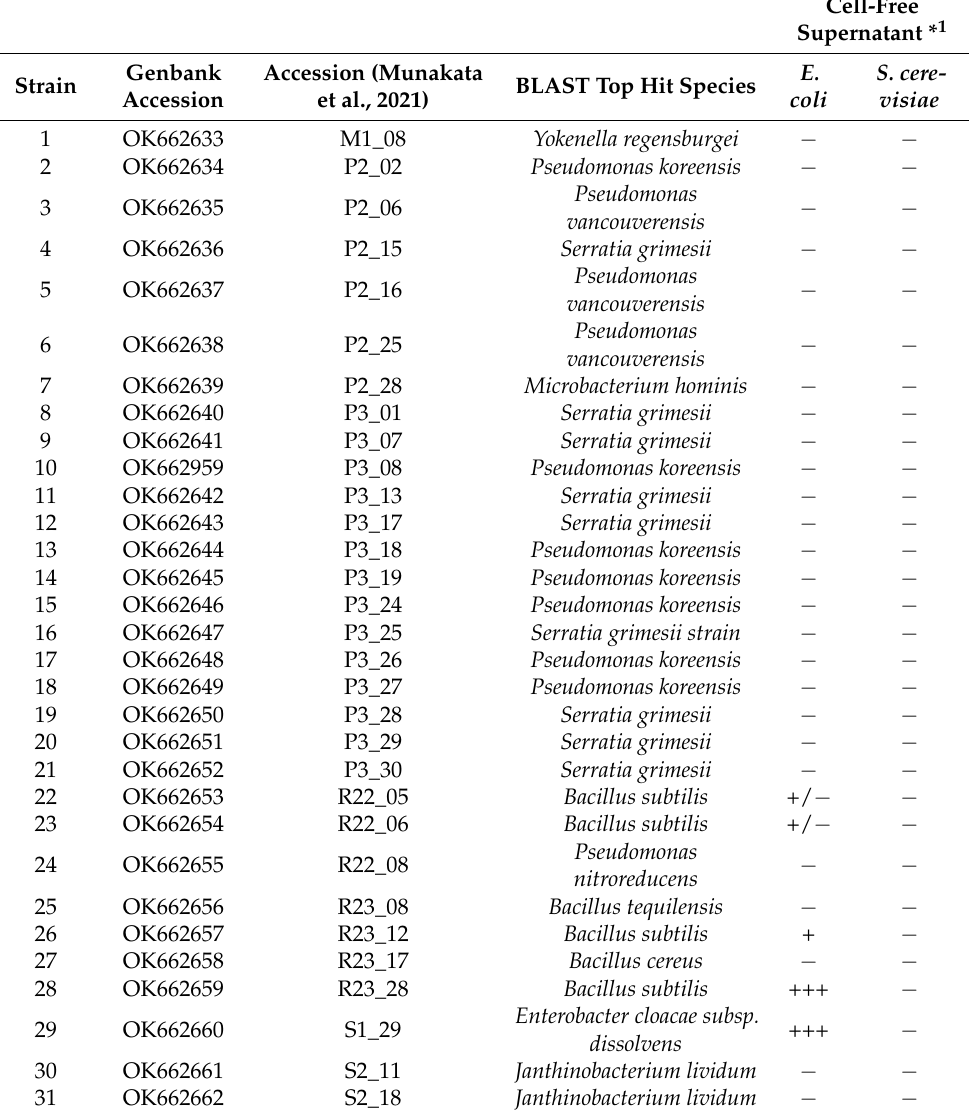
Table 1. Summary of the in vitro growth inhibition activities of the cell-free supernatants of the 31 vetiver bacterial endophytes against Escherichia coli and Saccharomyces cerevisiae